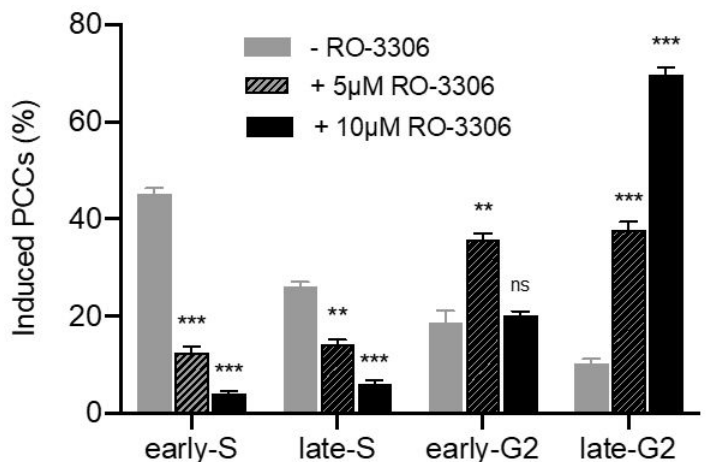
Figure 11. Cell cycle distribution of induced PCCs in multinucleated cells generated by fusion of asynchronous CHO cells. Frequencies in four di ff erent cell cycle phase categories of PCCs in asynchronous heterophasic multinucleated cells generated by cell fusion procedures using exponentially growing CHO cells. In the absence of RO-3306, 45% of PCCs observed are in early-S, 26% in late-S phase, 19% in early-G2, and 10% in late-G2; whereas in the presence of 5 µ M RO-3306 for 12 h, only 12% were in early-S, 14% in late-S, 36% in early-G2, and 38% in late-G2. When 10 µ M RO-3306 was used to inhibit CDK1 and delay more e ff ectively the entrance of main nuclei into mitosis, 90% of heterophasic nuclei proceeded into early-G2 and late-G2, without any chromosome shattering, whereas only 10% of PCCs were left in early-S and late-S cell cycle phase, exhibiting chromosome shattering. The use of RO-3306 to synchronize heterophasic nuclei in multinucleated cells demonstrates that the extent of chromosome shattering is inversely related to the degree of synchronization achieved. (Mean ± SEM based on three independent experiments; a total of 1083 induced PCC spreads were